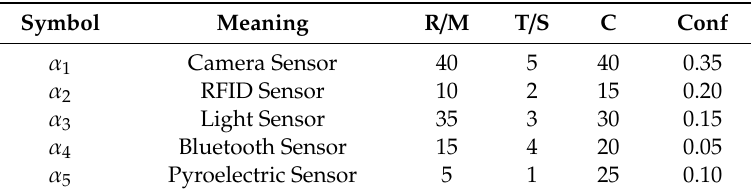
Table 1. The parameters of